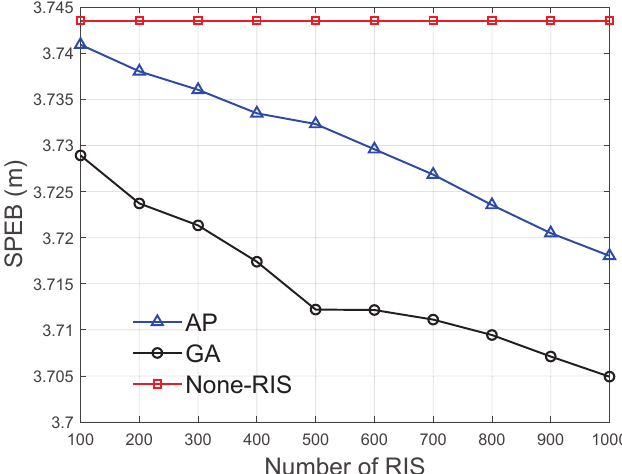
Figure 2. SPEB with different numbers of RIS.